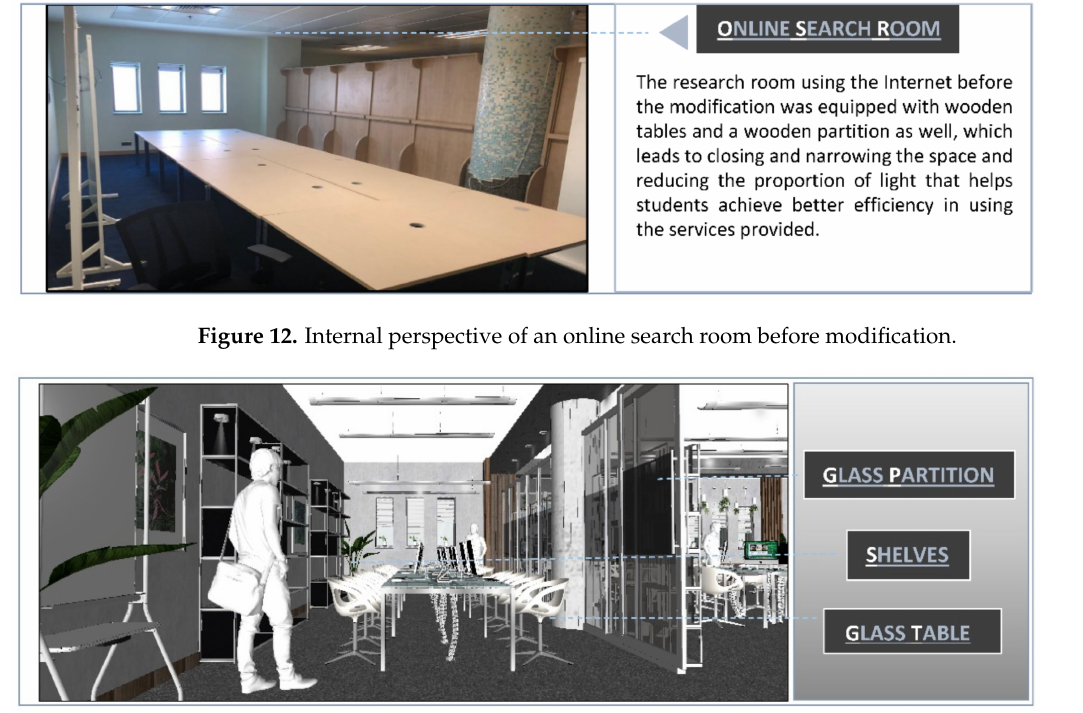
Figure 13. Internal perspective of an online search room suitable for 16 researchers.